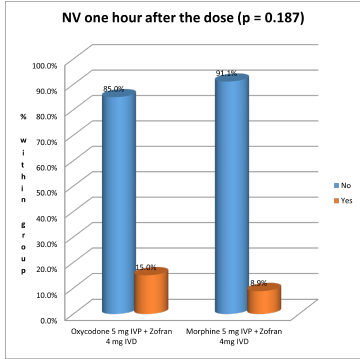
Figure 2. Nausea and vomiting incidence one hour after the dose